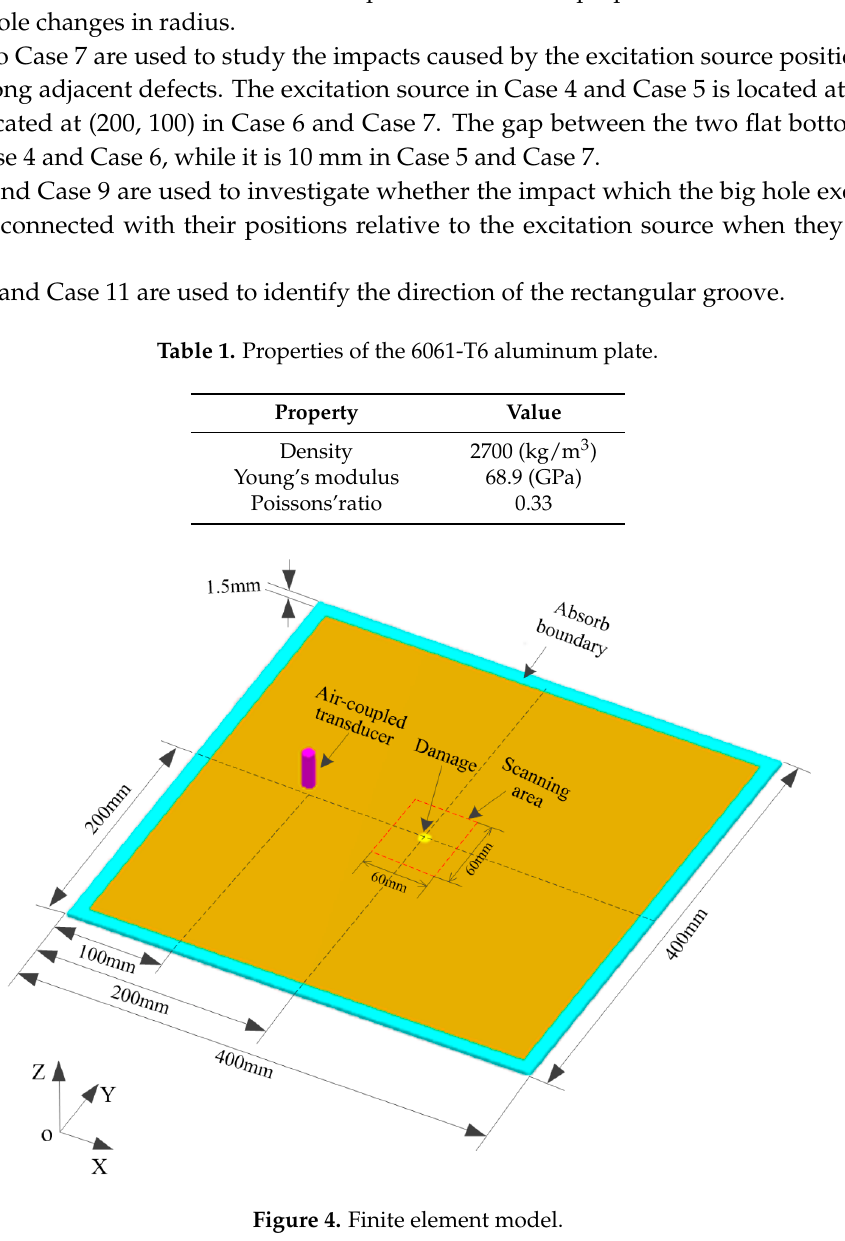
Figure 5. The excitation signal in the ( a ) time ‐ domain; ( b ) frequency ‐ domain. Table 2. Specimen parameters. Specimen